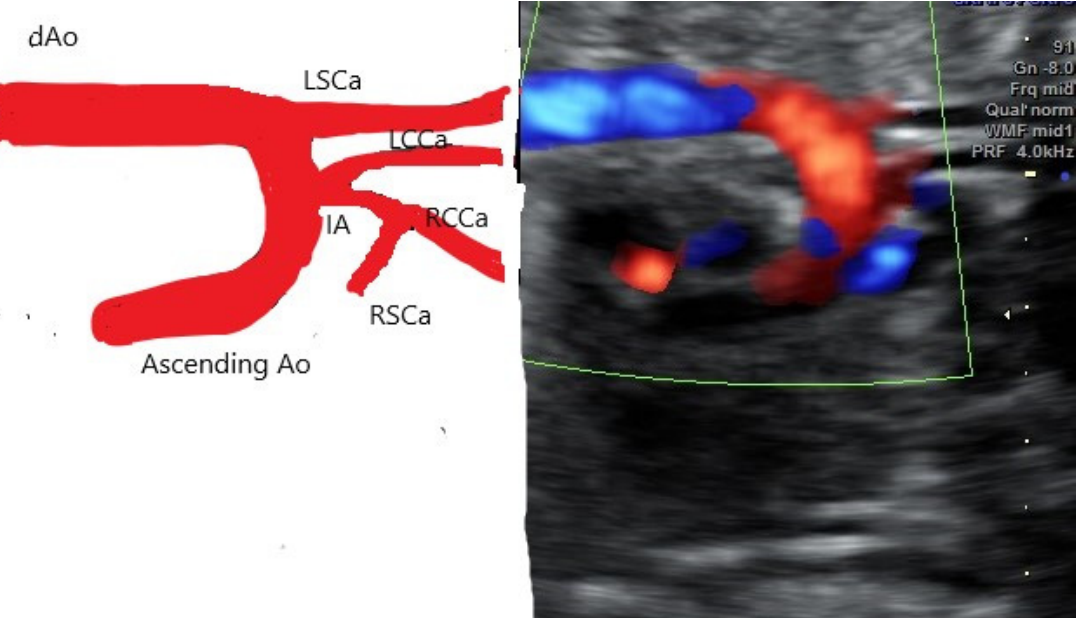
Figure 3. Figure 2 Schematic figure of AAAV type B IA—and LCCa are arising in the same spot the same spot. IA divides furtherly into RSCa and RCCa. This is most common AAAV variant. same spot. IA divides furtherly into RSCa and RCCa. This is most common AAAV